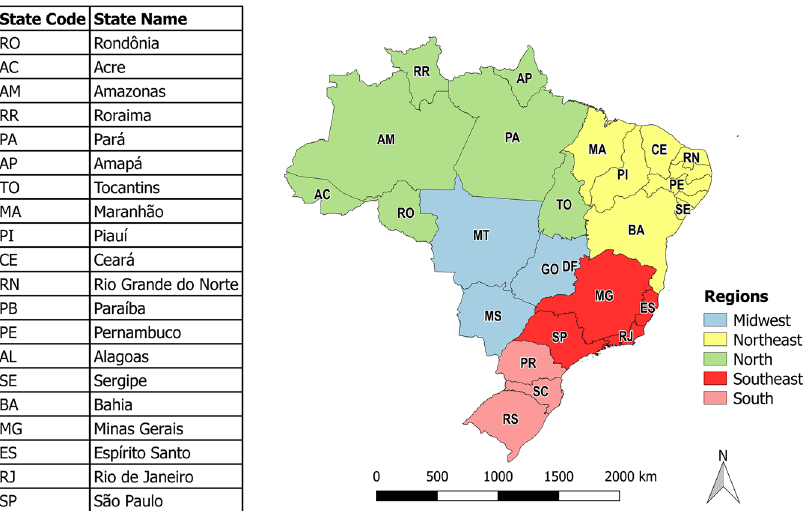
Figure 10. Administrative division of Brazil. The map was generated using public domain shapefiles provided by the Brazilian Institute of Geography and Statistics (https:// geoftp. ibge. gov. br/ organ izacao_ do_ terri torio/ malhas_ terri toria is/ malhas_ munic ipais/ munic ipio_ 2021/ Brasil/ BR/ BR_ Munic ipios_ 2021. zip). The figure was generated by the authors using the QGIS software, version 3.16.11 (https:// qgis.